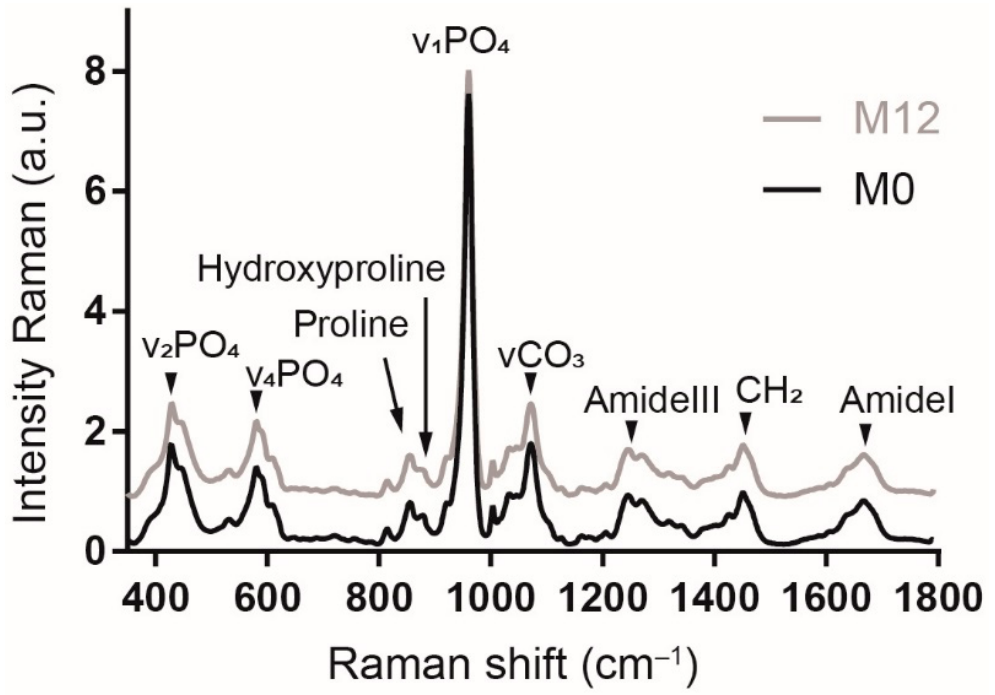
Figure 4. Comparison of averaged Raman spectra at baseline (M0) and after 12 months (M12). Each Raman spectrum is averaged over the 6 bodies and both ribs. The spectrum M12 is shifted along the y -axis to facilitate the comparison of M0 and M12. The shift does not have a biological or instrumental significance.